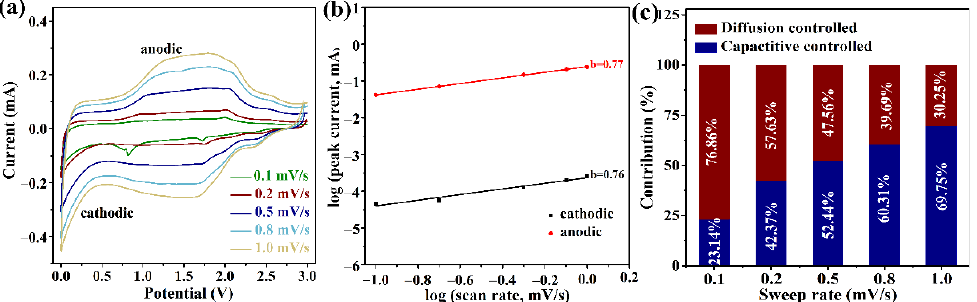
Figure 8. ( a ) CV profiles at different sweep rates; ( b ) relationship between log( i ) vs log( v ); and ( c ) contribution ratio of capacities at different sweep rates for the Ti 3 C 2 T x -T(O) anodes.